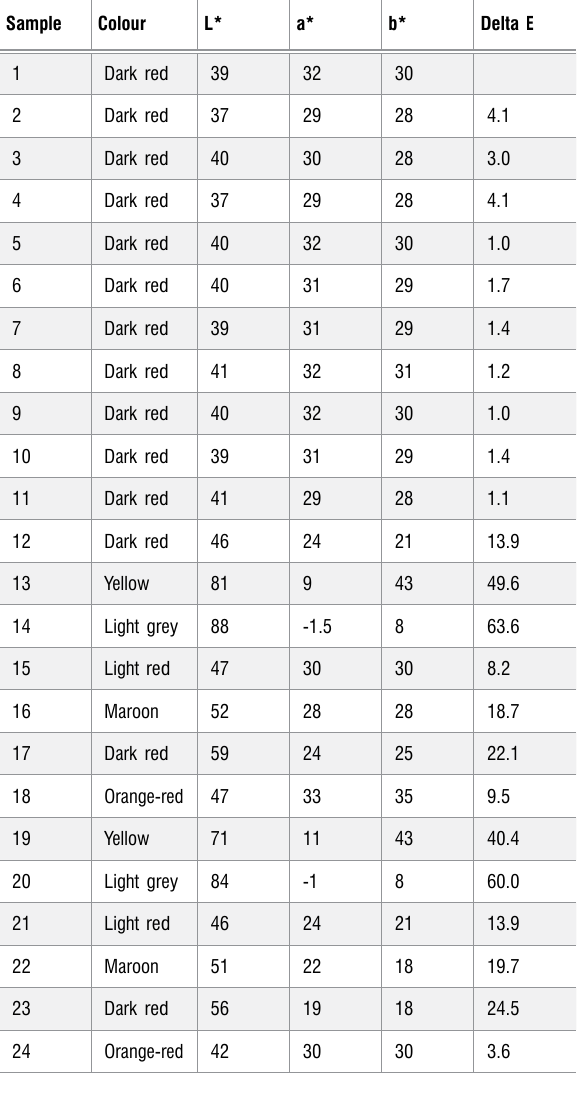
Table 3: Colourimetric L*a*b* values for experimental ochre samples Sample